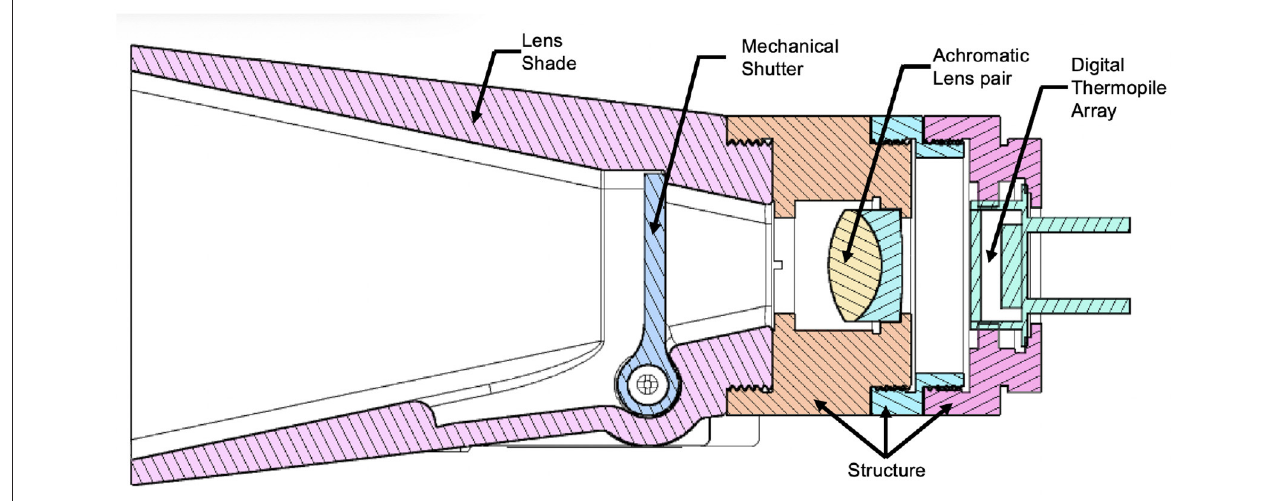
FIGURE 3 | Shortwave sensor cross section, with shutter in closed position. Adaptable system using c-mount components, and 3D printed lens shade.